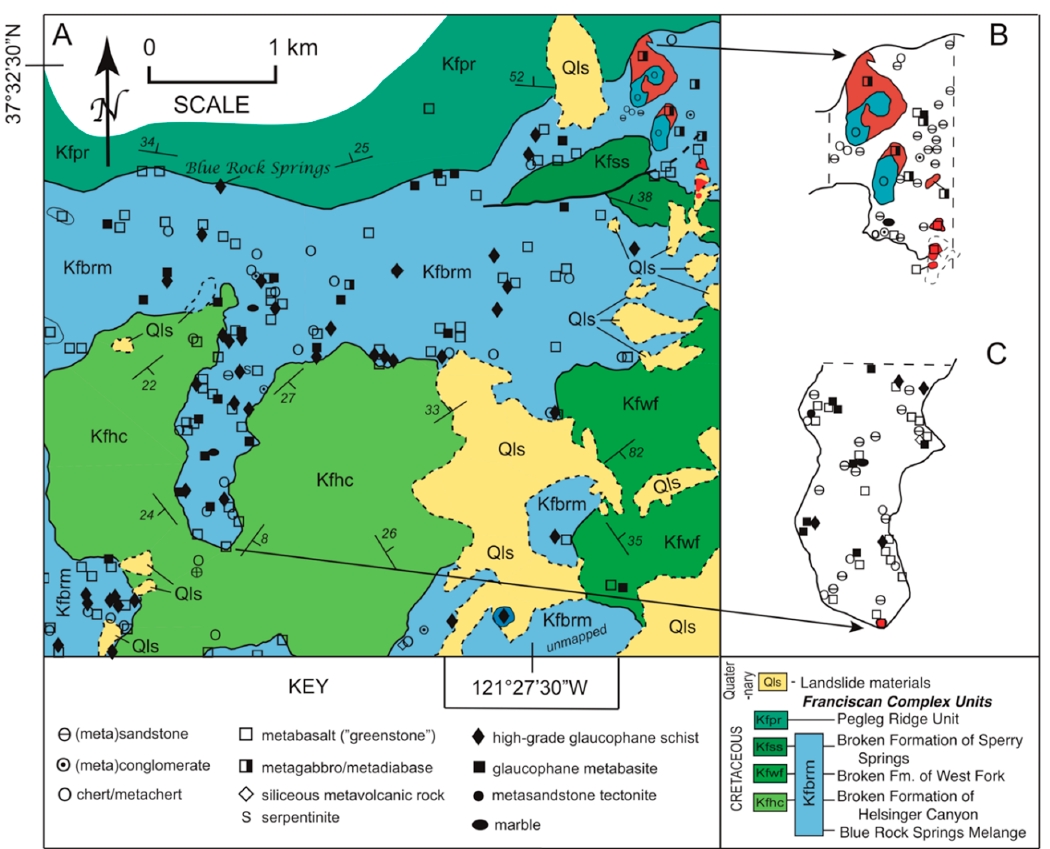
Figure 4. Maps of parts of the Blue Rock Spring Mélange. ( A ) General map of the Blue Rock Spring Mélange (Kfbrm) in the SW1/4 of the Lone Tree Creek 7.5’ Quadrangle, California. Note metasandstone slabs associated with and largely surrounded by the Kfbrm (including Kfss, the metawacke of Sperry Springs; Kfwf, the Metawacke of West Fork; and Kfhc, the Metawacke of Helsinger Canyon (units from [2]). Qls is Quaternary landslide material. The structurally overlying unit is the Broken to Dismembered Formation of Pegleg Ridge (Kfpr)/Pegleg Ridge Mélange (nature of unit is unresolved). Exotic blocks are diverse but not evenly distributed in the Kfbrm. Details of block distribution showing more blocks than the general map are shown for two areas of the mélange (shown in B and C). ( B ) Block map of area B, which contains some large masses of ocean plate stratigraphy (OPS), specifically metagabbro/metadiabase overlain by metachert (with local, red, interpillow weakly recrystallized metalimestone). Although the OPS blocks are the largest, native and exotic metasandstones are most abundant. The key shows other exotic block types. ( C ) Map of blocks in area C. See key for rock types. Metsandstones and metvolcanic metabasites are the most abundant, but high-grade blocks (mostly glaucophane schist) and lower-grade glaucophane metabasites and zeolite to greenschist facies metabasites (“greenstones”) are relatively common. Note that non-oceanic rocks such as siliceous volcanic rocks are very minor components of the mélange. The maps show a representative sample of block types in the larger mélange, and it is likely that not every large block was discovered, but in general, only blocks larger than about 1 meter in diameter are mapped. An exception is that small masses of marble (any > 15 cm) are included on the map.